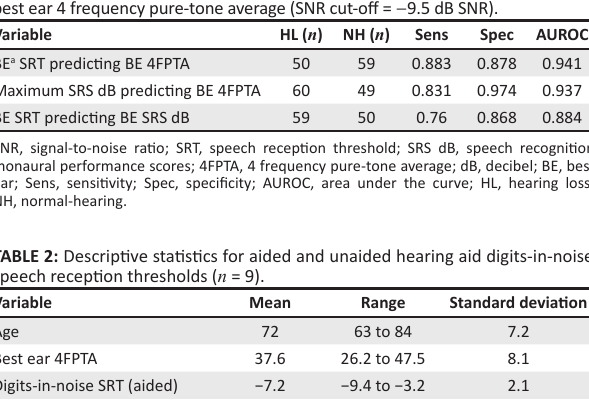
TABLE 1: Performance of digits-in-noise speech reception threshold and maximum speech recognition monaural performance scores to predict normal and